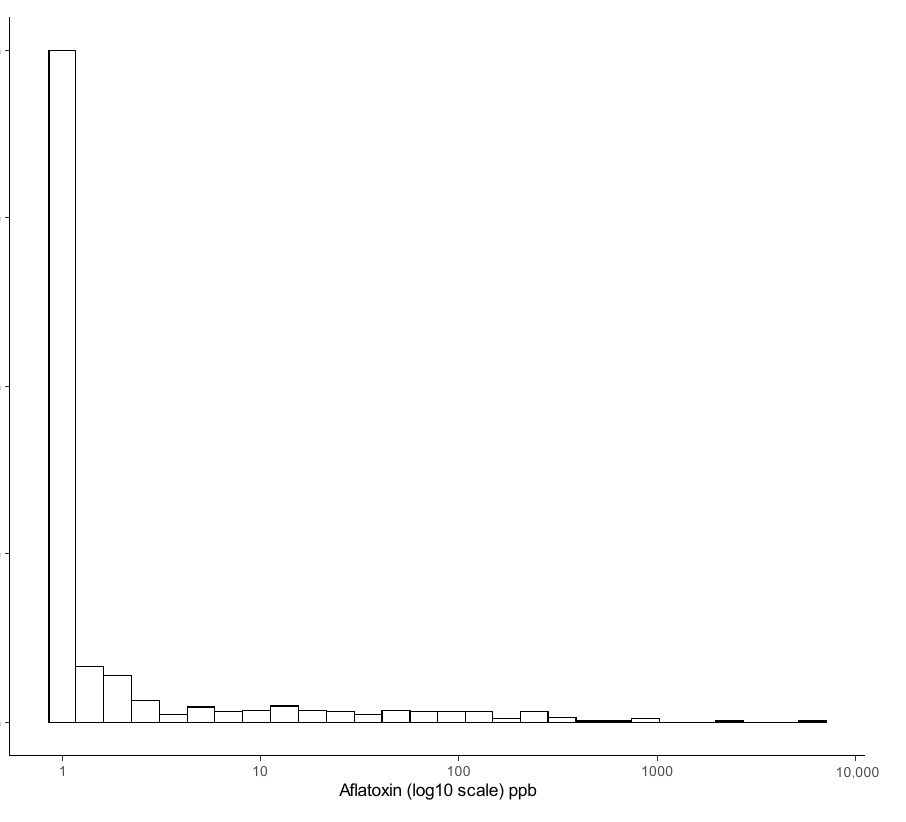
Figure 2. A histogram showing the distribution of aflatoxin values measure on 571 maize samples taken from farms in Kenya and Tanzania.